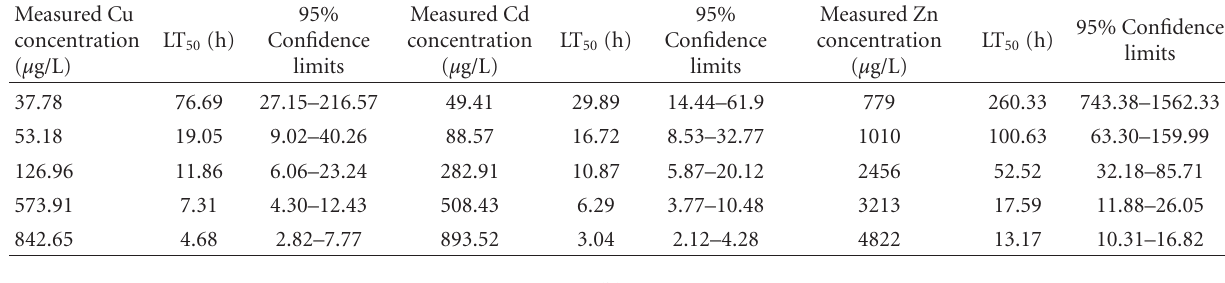
Table 1: Median lethal times (LT 50 ) for S. major exposed to di ff erent concentrations for Cu, Cd, Zn, Pb, Ni, Fe, Al, and Mn.